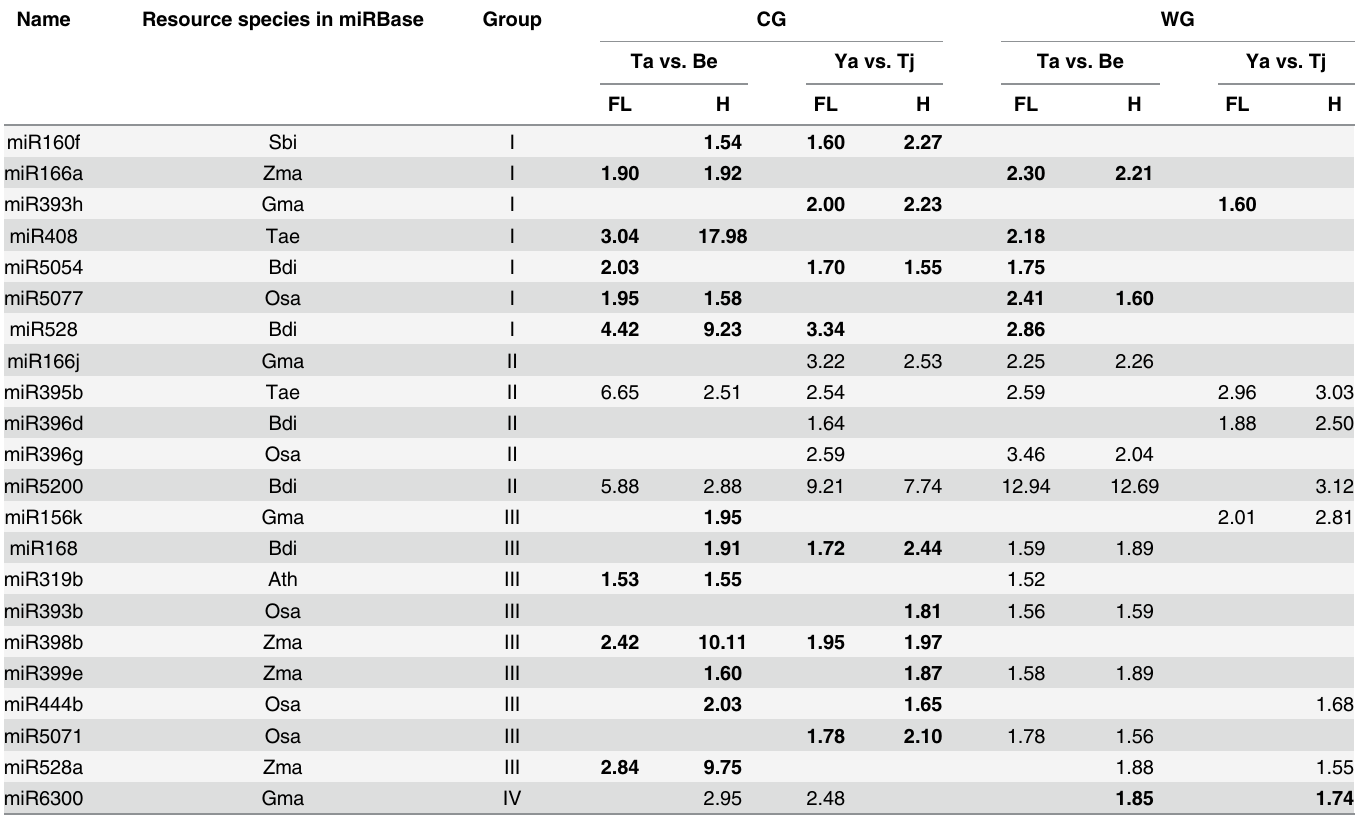
Table 3. Genotype-specific durum miRNAs showed four different regulation patterns to water deficit